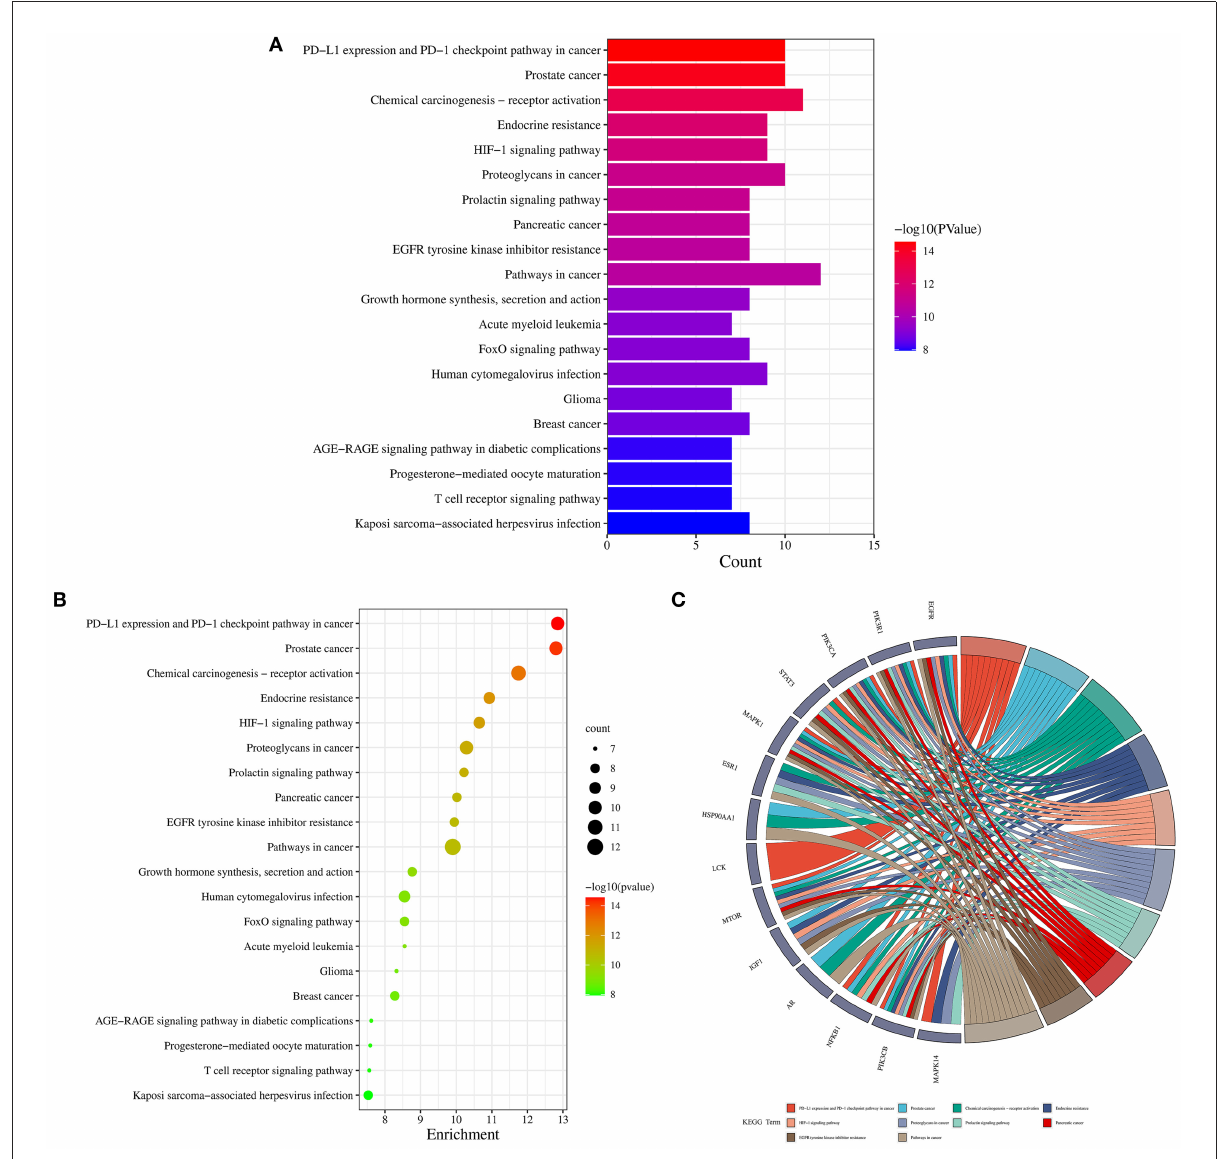
FIGURE6 Kyoto Encyclopedia of genes and genomes enrichment analysis findings in 1,25-dihydroxyvitamin D against COVID-19/DM. Bar chart of KEGG pathways (A) , bubble chart of KEGG pathways (B) , circle chart of hub targets and KEGG pathways (C) .